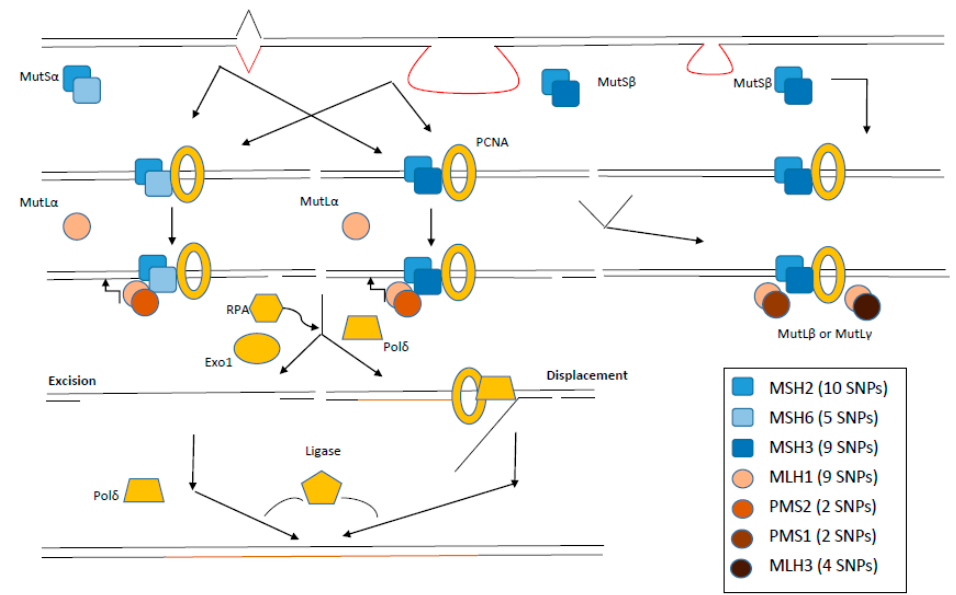
Figure 1. Molecular principles of the eukaryotic MMR system. MutS α protein complexes recognise mainly nucleotide mismatches, whereas MutS β complexes recognise insertion–deletion loops. Further steps of MMR include interaction with MutL protein complexes and other proteins (exonucleases, replication proteins and polymerases). Numbers in brackets summarise the number of known pathogenic SNPs with F ≥ 5% in EUR population (adapted from the work in [34,35]). PCNA: Proliferating cell nuclear antigen; EXO1: Exonuclease 1; Pol δ : DNA polymerase δ ; RPA: Replication protein A.